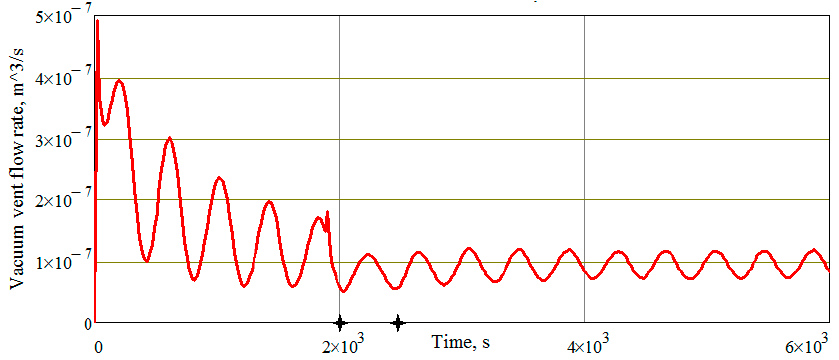
Figure 17. Change of the harmonic component ( a ) and amplitude ( b ) of the averaged pressure inside the unfilled regions during vacuum infusion.